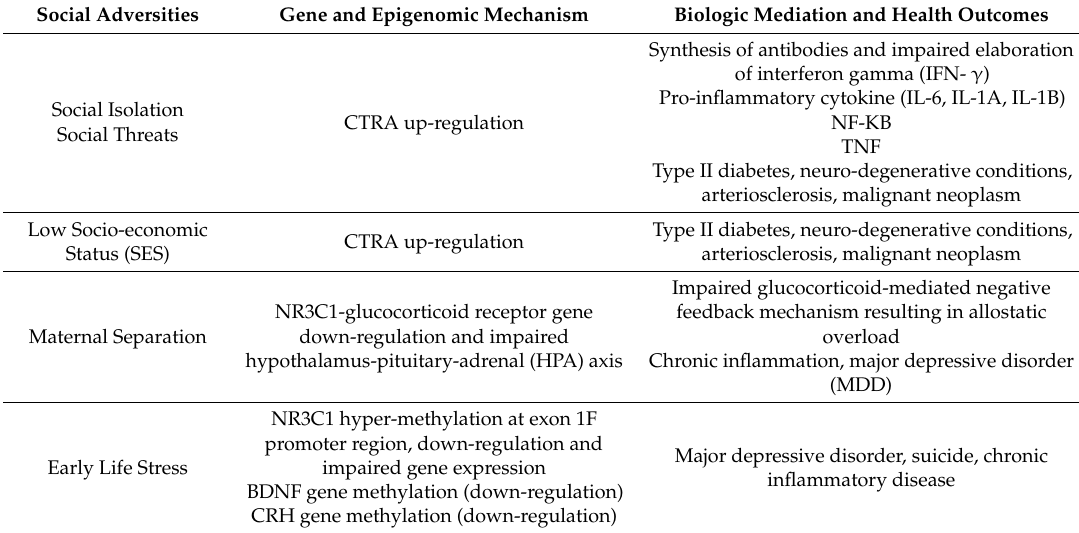
Table 1. Candidate genes implicated in social adversity and health